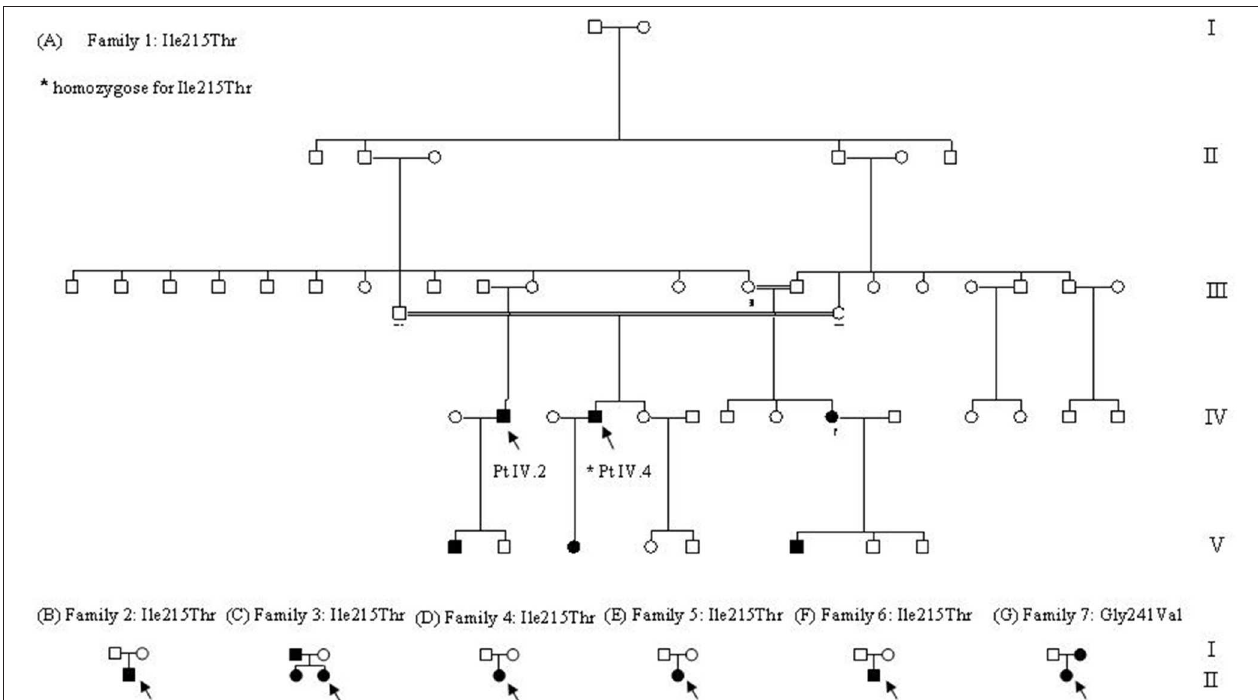
FIGURE 1 | Family trees. (A–F) Family trees of families that carried p.Ile215Thr. In the picture, we indicated by arrows the two probands, IV.2 heterozygote, and IV.4 homozygote for the target mutation. As depicted by the doubled lines, two marriages between relatives occurred in this family, and only one homozygote was generated (*). (G) Family tree of the only family carrying